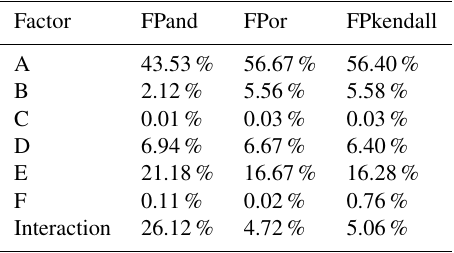
Table 11. Contributions of parameter uncertainties obtained by three-level ANOVA to predictive failure probabilities for a design return period of 200 years and a service time of 30